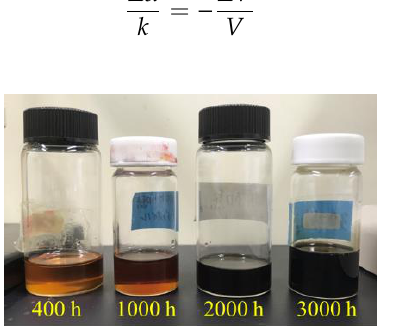
Figure 8. Photos of the heated engine oils. The lids of the vessels were open during the heating.